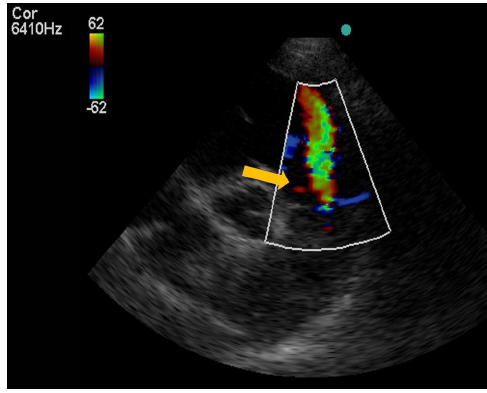
Figure 2. Echocardiographic Color Doppler image of the right ventricular outflow tract showing moderate pulmonary regurgitation.